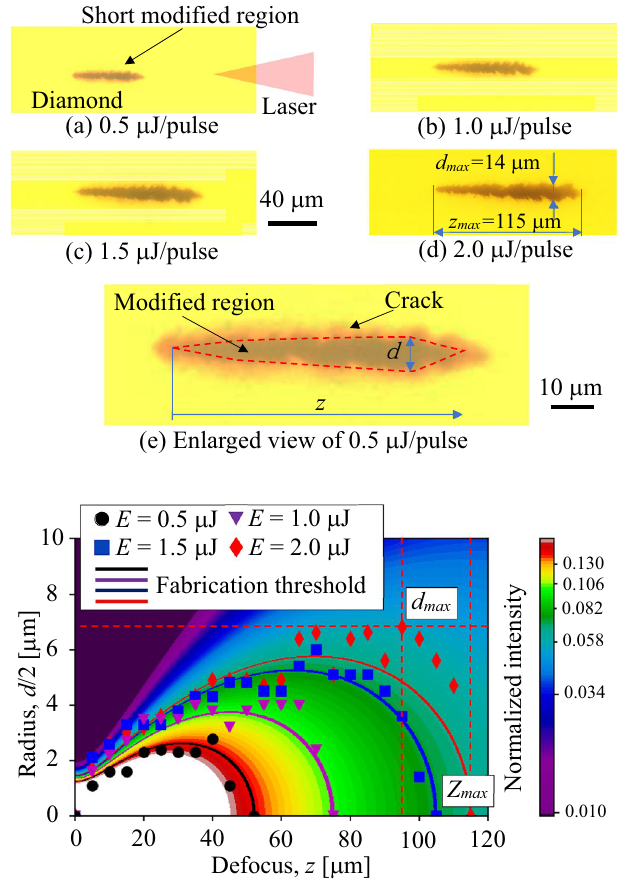
Figure 1. Micrographs of short modified regions and relationship between diameter of short modified regions and beam fluence